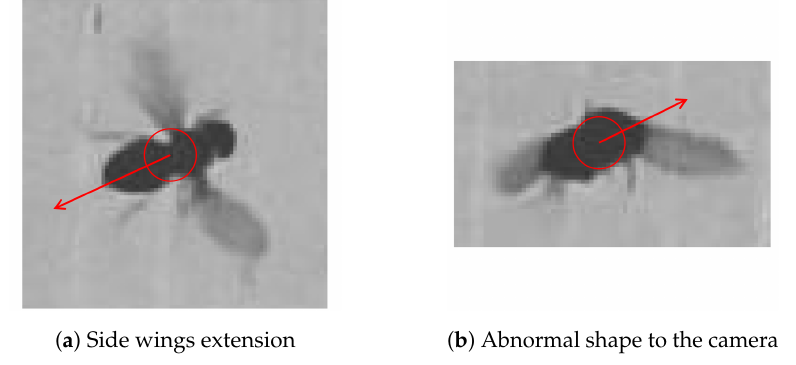
Figure 12. ( a ) Fly performing side wings extension and ( b ) abnormal shape detected by the camera that make heading direction fail. Having its wings in a position different from the normal wings position causes the system to fail to determine the heading